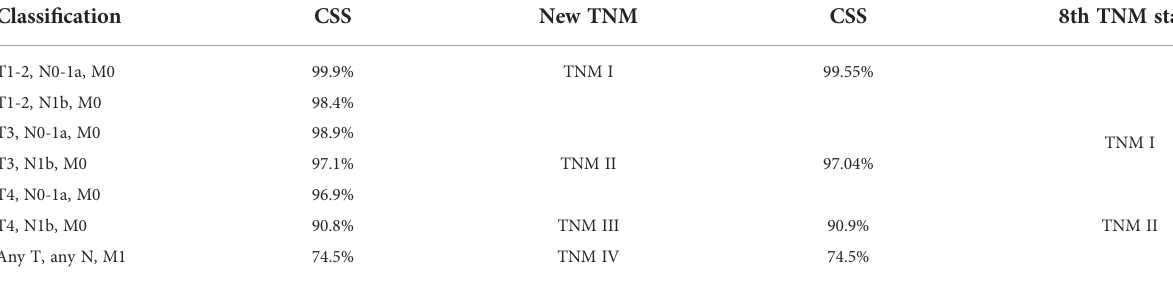
TABLE 3 Proposal of new modi fi ed TNM staging system for younger DTC patients.